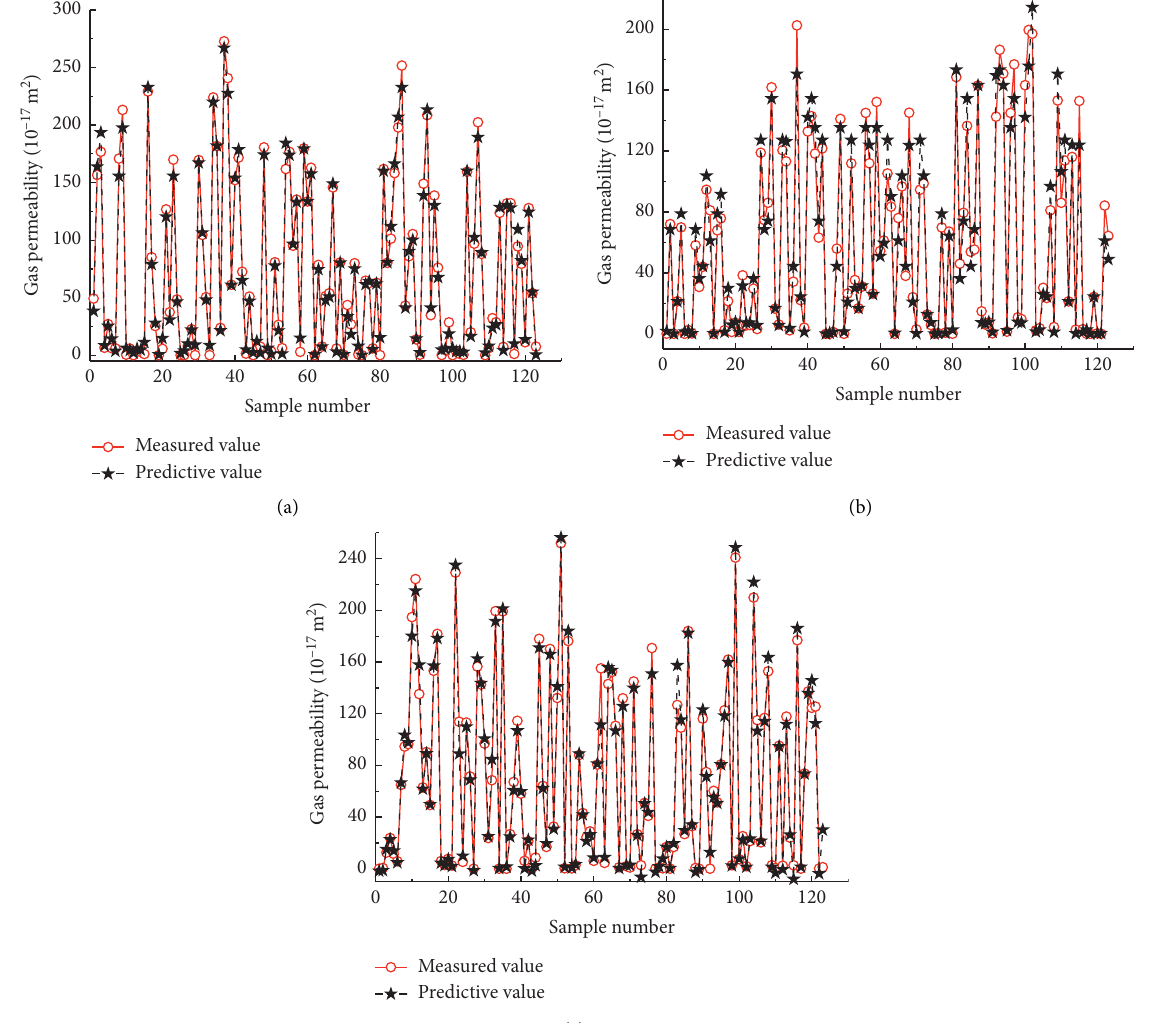
Figure 9: Predictive performance of the models for the testing dataset. (a) MEA-SVM. (b) GA-SVM. (c)